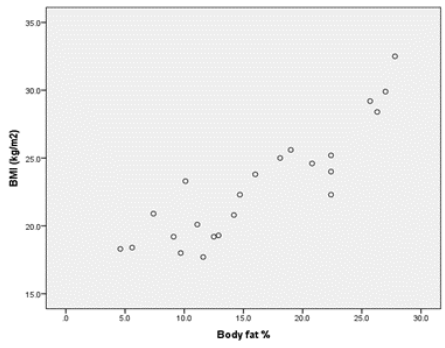
Figure 1. Correlation between BMI and body fat % for the group of boys without ID.